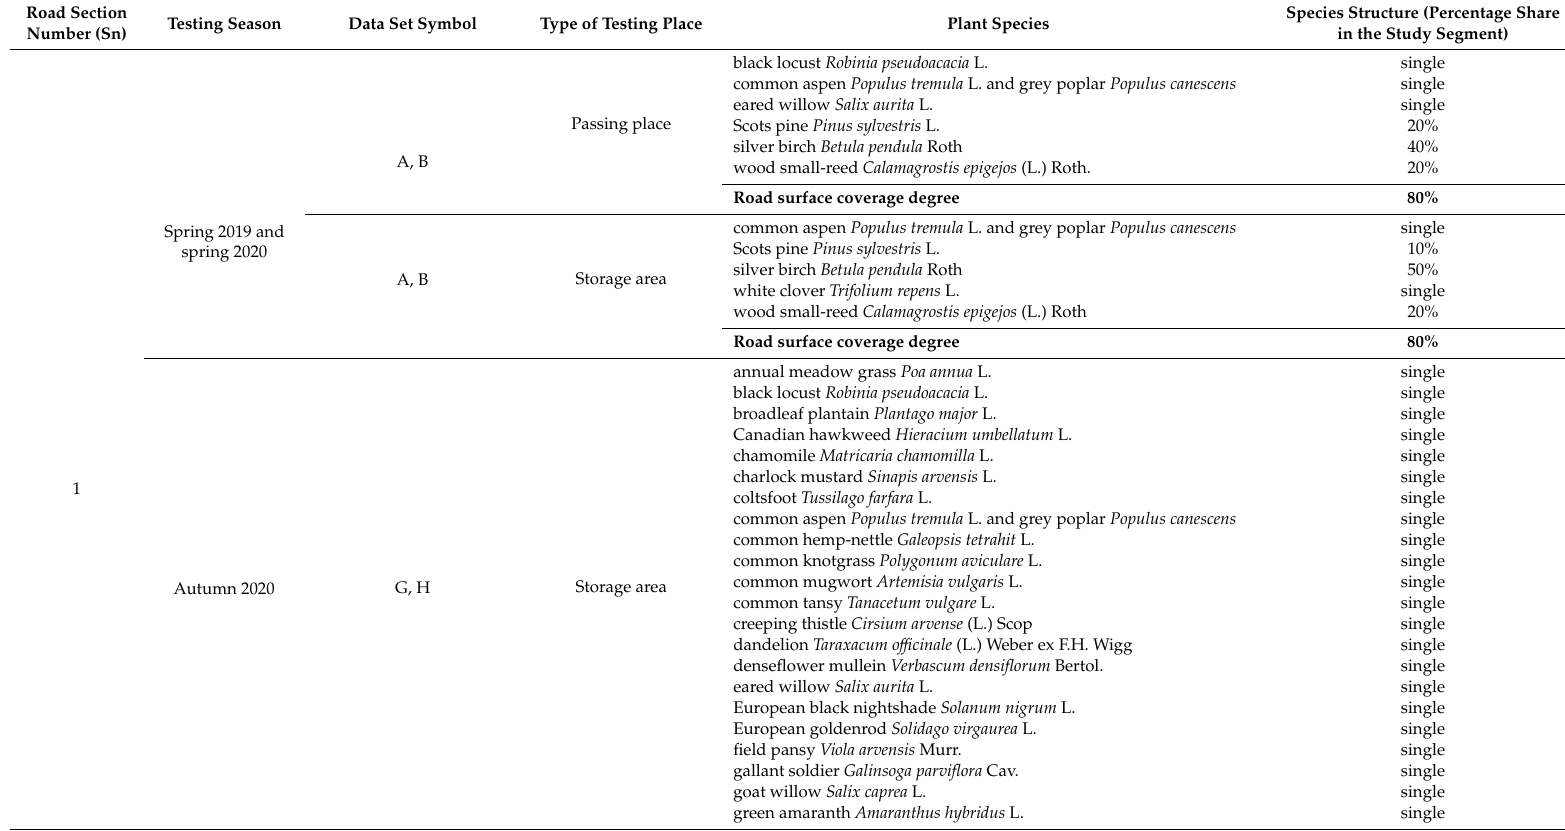
Table 3. The vegetation inventory on bearing capacity research area - experimental sections (passing area and storage